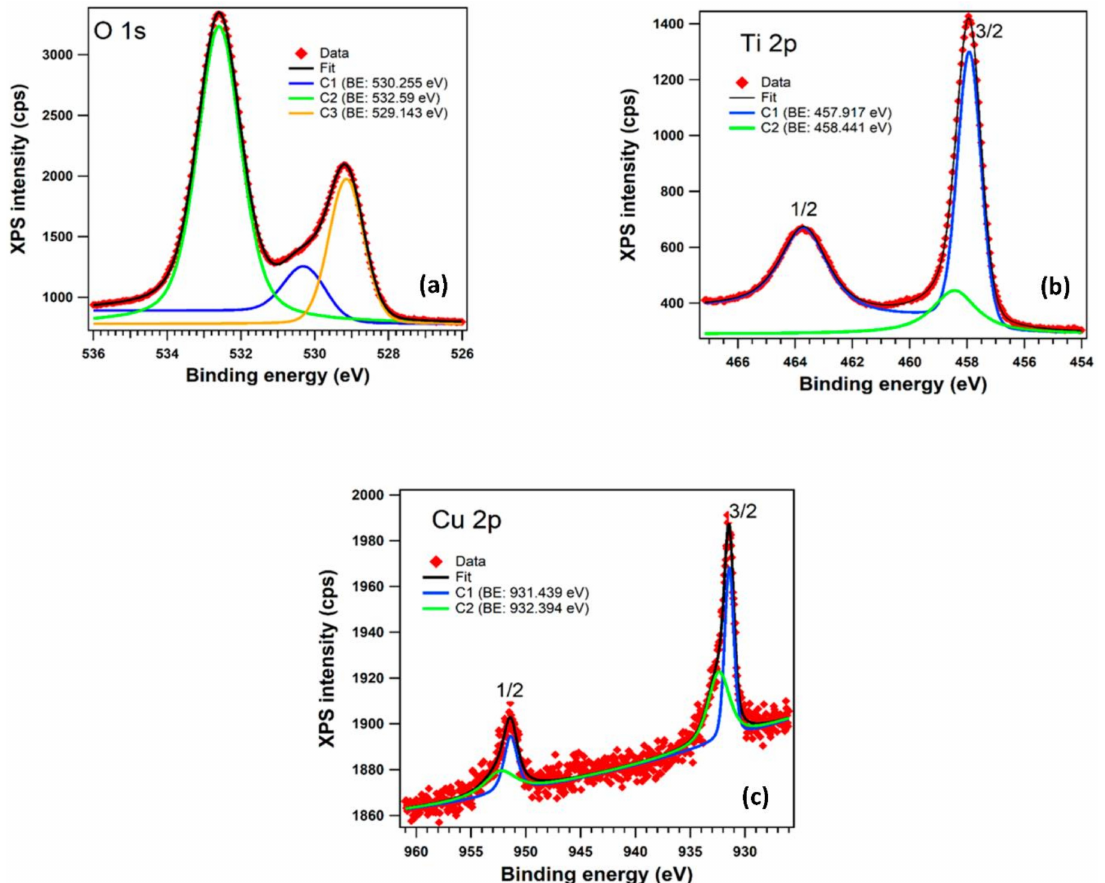
Figure 9. XPS spectra for core levels of 2% copper-doped TiO 2 powder: ( a ) O 1s; ( b ) Ti 2p and ( c ) Cu 2p. In all graphs, the red symbols are the experimental data, black lines are the fits, blue and green lines are the individual component.